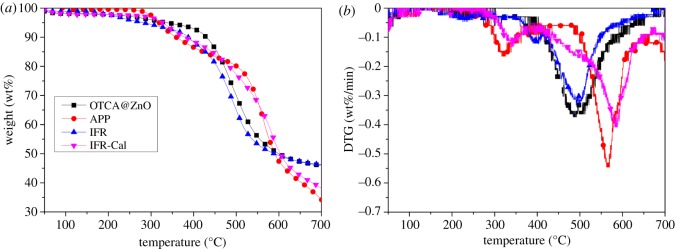
TGA (a) and DTG (b) curves of APP, IFR-3 and IFR-3 calculation under N2 atmosphere.